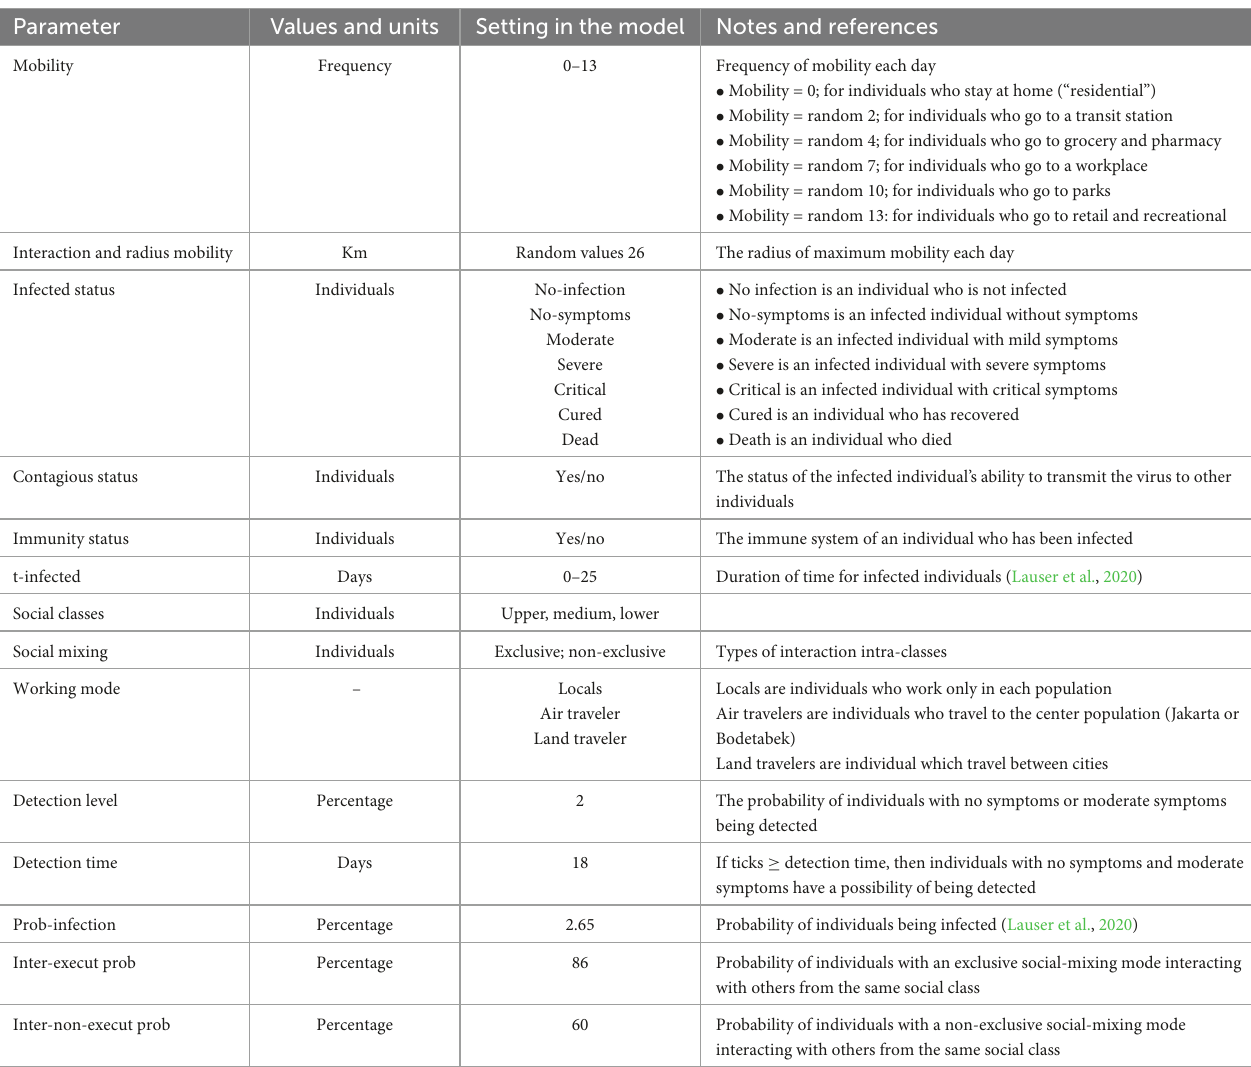
TABLE 1 Parameters values and settings for the SAMPAN model. Parameter Values and units Setting in the